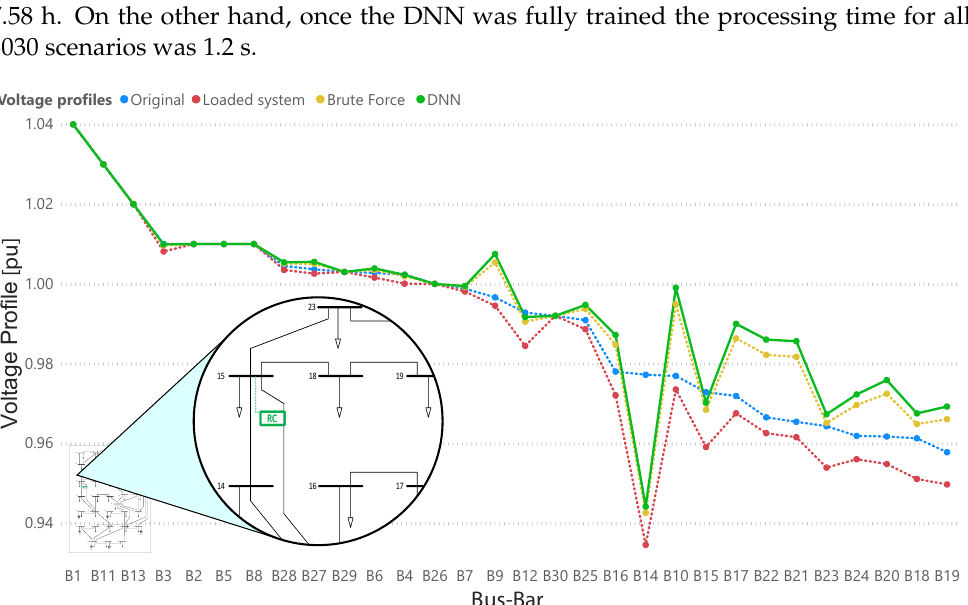
Figure 10. Voltage profiles for 30 bus-bar system: original system, loaded system, BFA and DNN compensation—where DNN results are better than